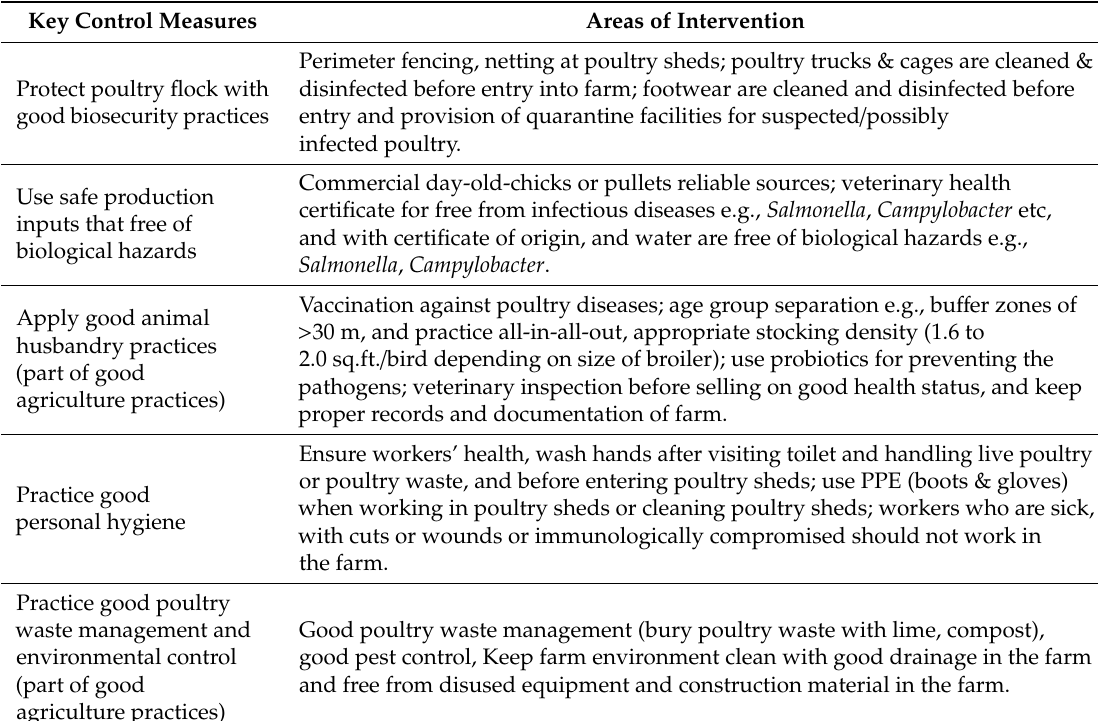
Table 1. Five key biological control measures (bacteria) for safe broiler